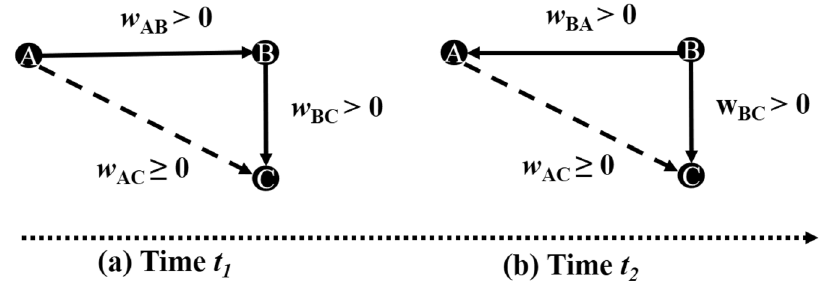
Figure 3. Illustration of the method on a triplet with directed interaction from A to B and B to C at a given instant t 1 , with leadership switching from A to B at another instant t 2 . Note that dashed line indicates whether the measures of causality are capable to detect or not the presence of direct/indirect interaction between A and = > or w C with either w 0 AC AC